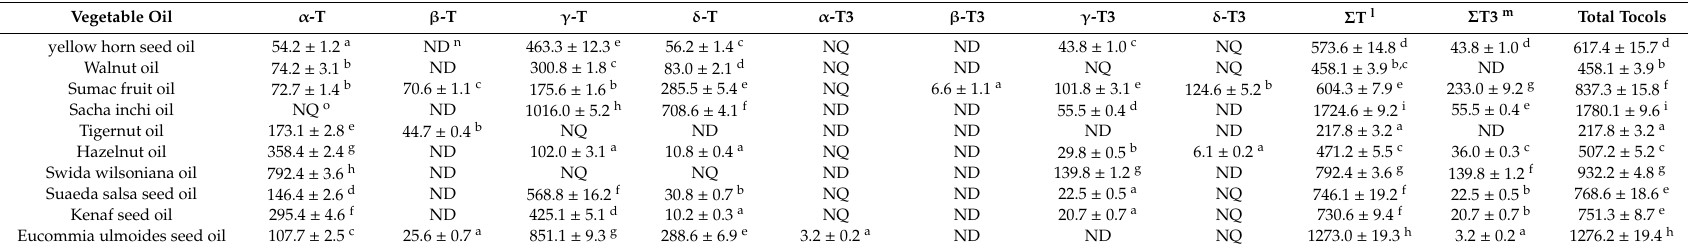
Table 3. The compositions and contents of tocols in the refined new types of vegetable oil k (mg /